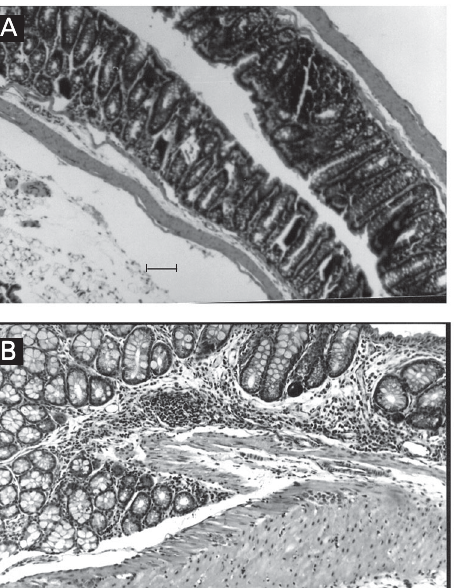
Figure 1. Effect of intrarectal ethanol administration on colon morphology (A, B) and cytokine production by lymphoid organs (C, D). Mice received one intra- rectal administration of either 0.2 ml saline (A, and dark gray columns in C and D) or 50% ethanol (B, and light gray col- umns in C and D) and were chal- lenged with either saline or etha- nol intrarectally 5 days later. Three days later, histological analysis of the large intestine was performed (A, B). Tissue was stained with hematoxylin and eosin. Inguinal (iLN), mes- enteric (mLN) and cecal (cLN) lymph nodes as well as spleen cells were isolated, stimulated in vitro with concanavalin A and supernatants were collected 72 h later to measure cytokine production by quantitative ELISA (C, D). P < 0.05 compared to control mice (unpaired t -test). ND = not determined. Magnifi- cation bars: A = 50 µm; B = 30